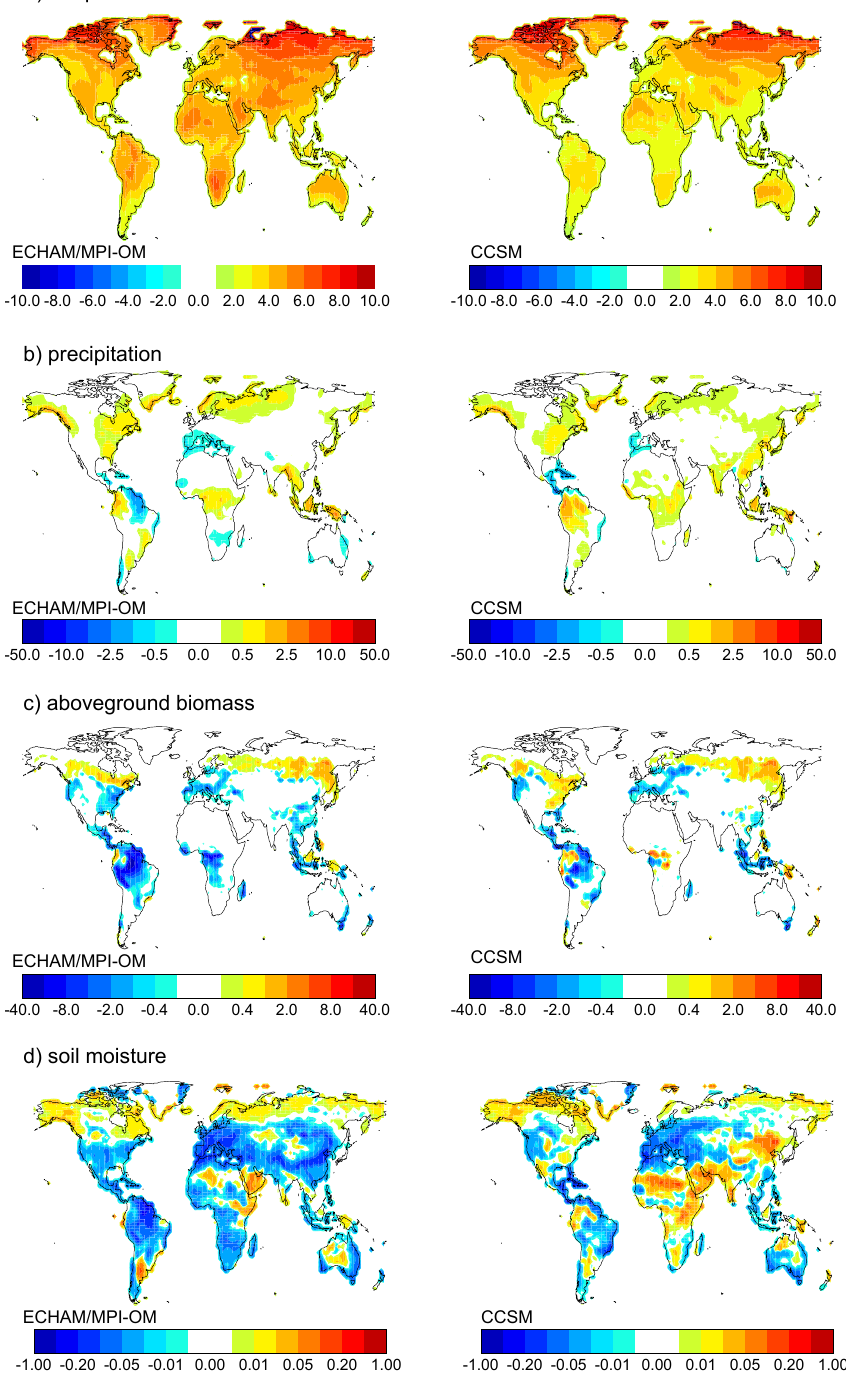
Fig. 5. Changes in climate parameters (annual mean) averaged over the period 2075–2099 compared to the control simulation with constant climate. Left side: ECHAM/MPI-OM (AB-45-E1 minus AB-CLIM-45), right side: CCSM (AB-45-C1 minus AB-CLIM-45). 1st row: temperature in [deg C]; 2nd row: precipitation in [mmd − 1 ]; 3rd row: aboveground biomass [kgCm − 2 ]; 4th row: soil moisture [fraction of the plant-available volumetric water content in the top 5cm of the soil